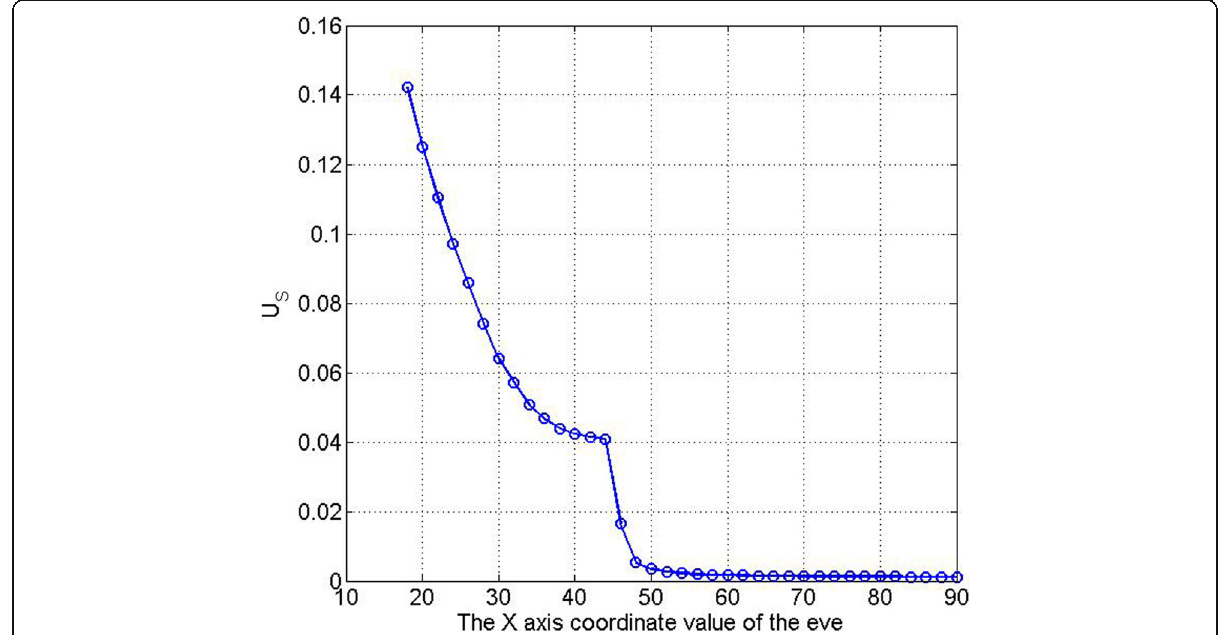
Fig. 7 The cooperative relay selection based on the total payment U S Vs the location change of eavesdropping